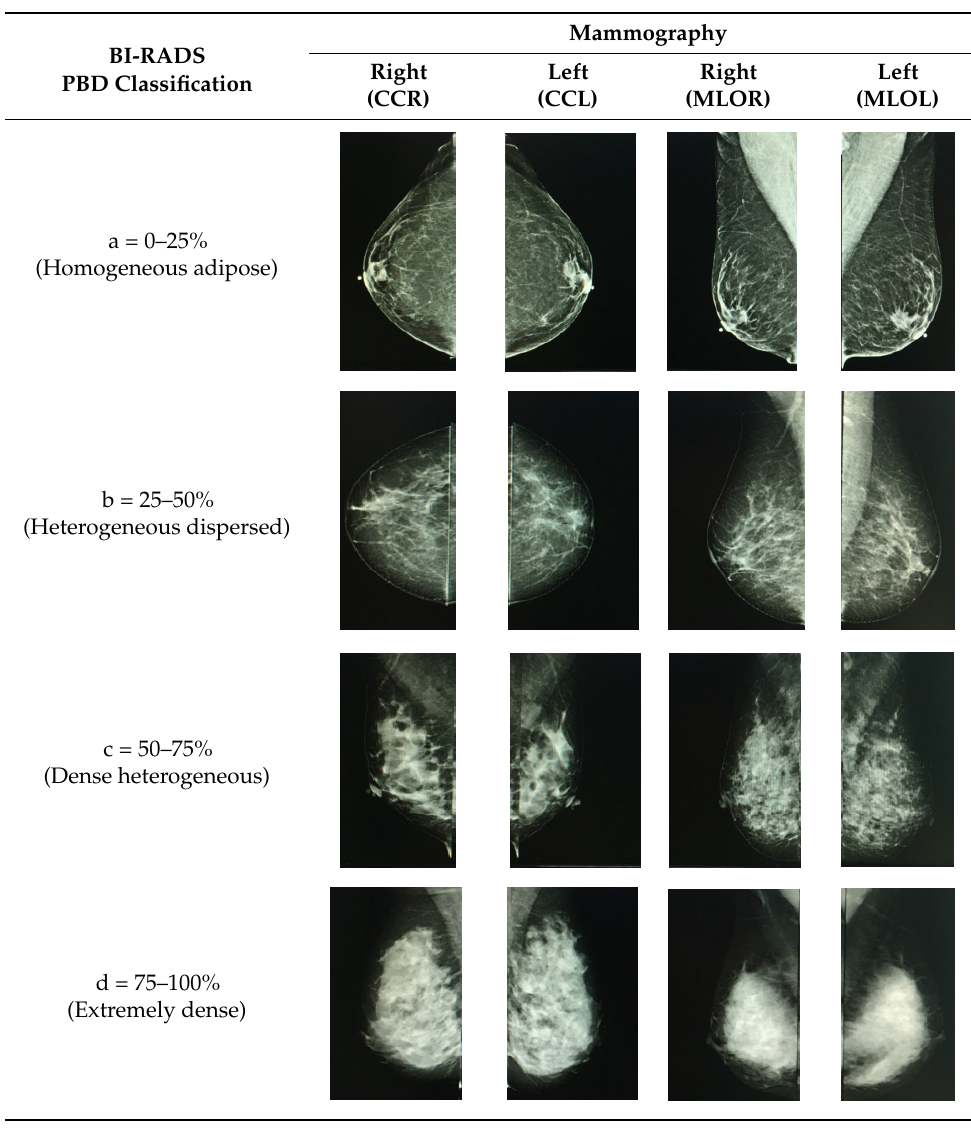
Table 1. BI-RADS classification and its relationship with mammography.